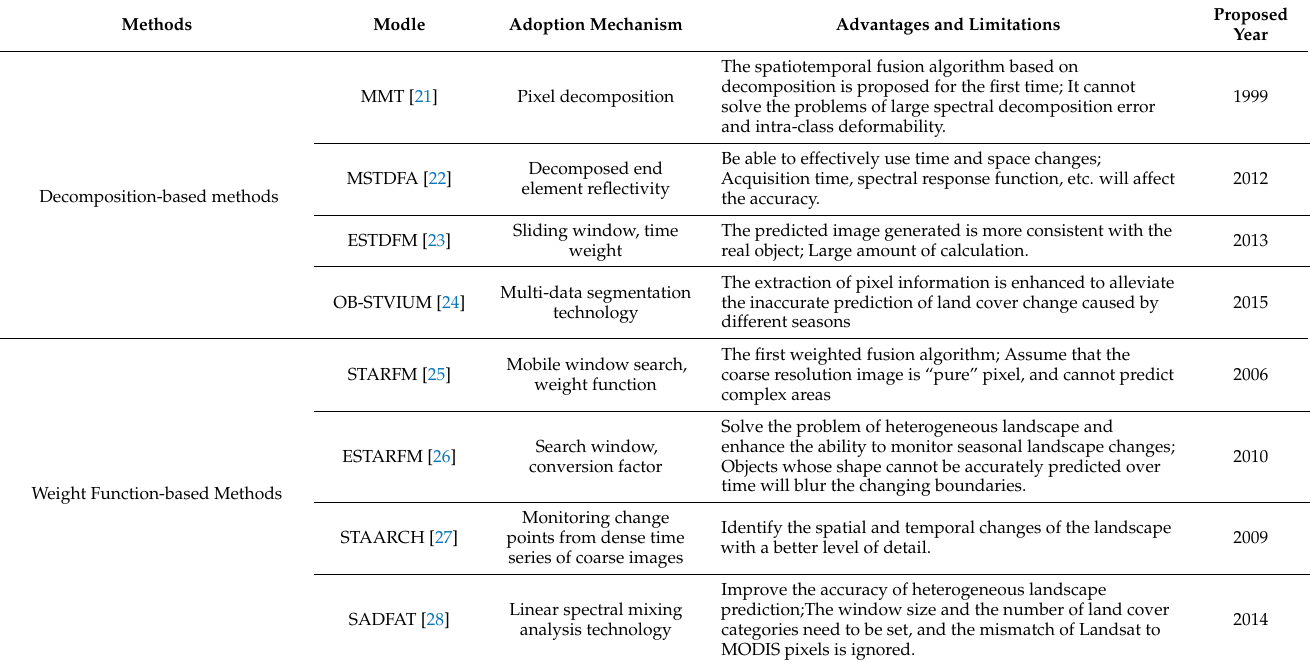
Table 1. Classification Comparison of Spatiotemporal Fusion Algorithms for Remote Sensing Images. Methods